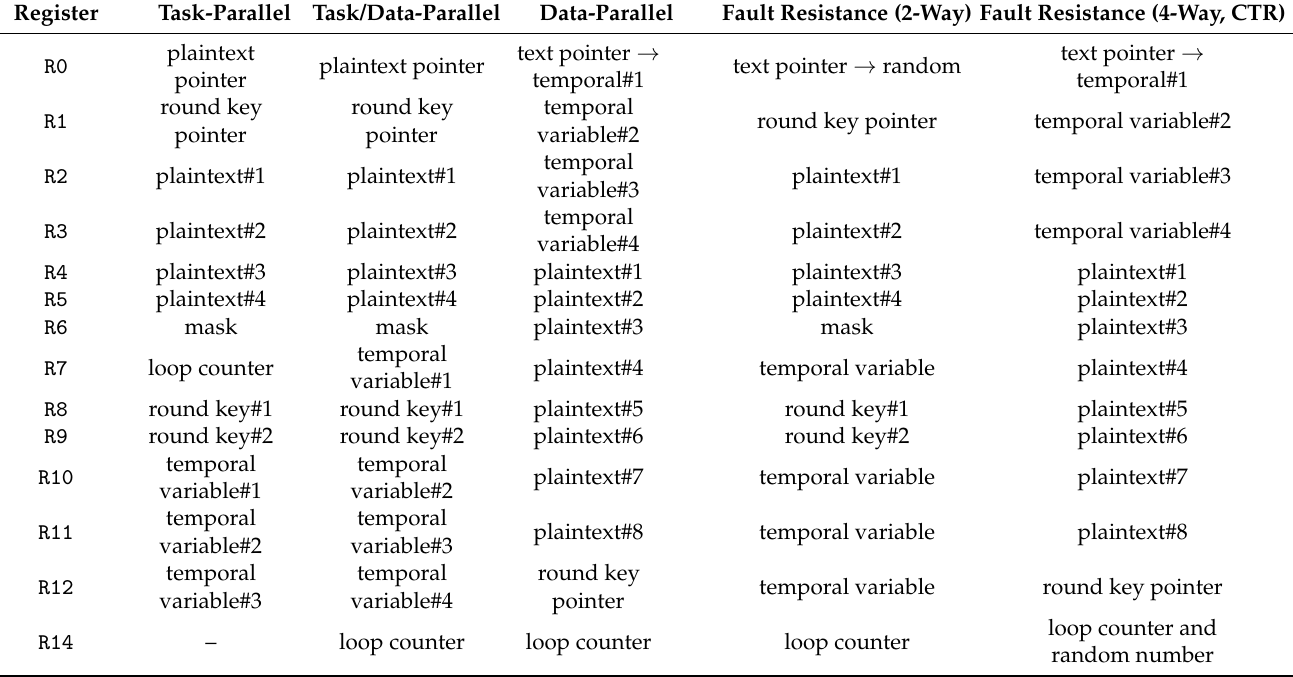
Table 2. Register details of parallel and fault-safe implementations on target